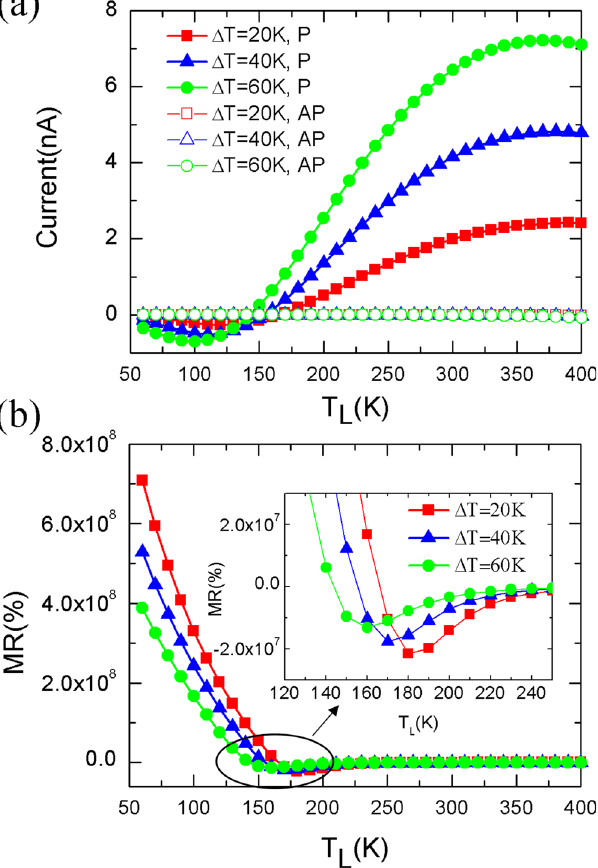
Figure 5. The total charge current and the thermal magnetoresistance. ( a ) The total charge current as a function of T L for P and AP spin configurations with ∆ T = 20, 40 and 60 K. ( b ) The thermal magnetoresistance as a function of T L . For clarity, the inset shows the magnetoresistance at the flex point with a smaller